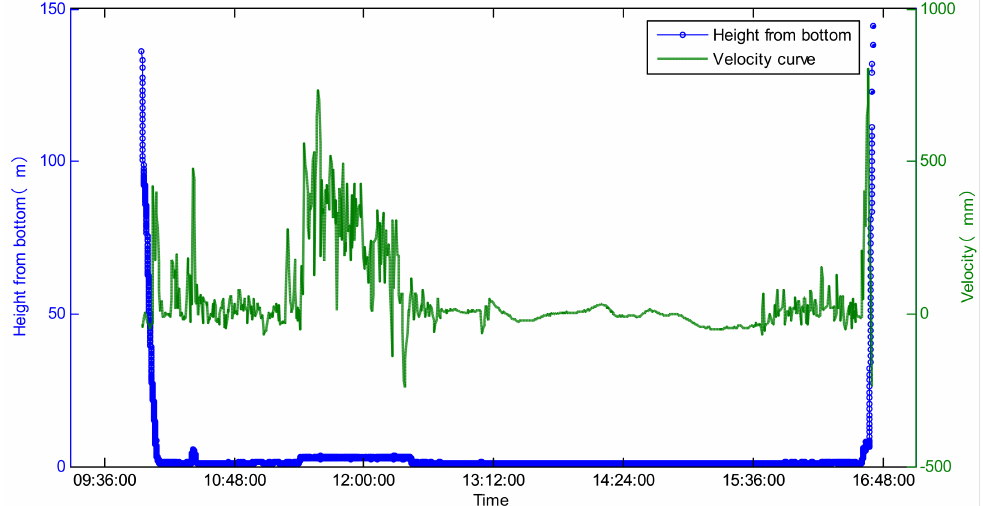
Figure 17. Maximum operating distance and velocity curve of the DVL.